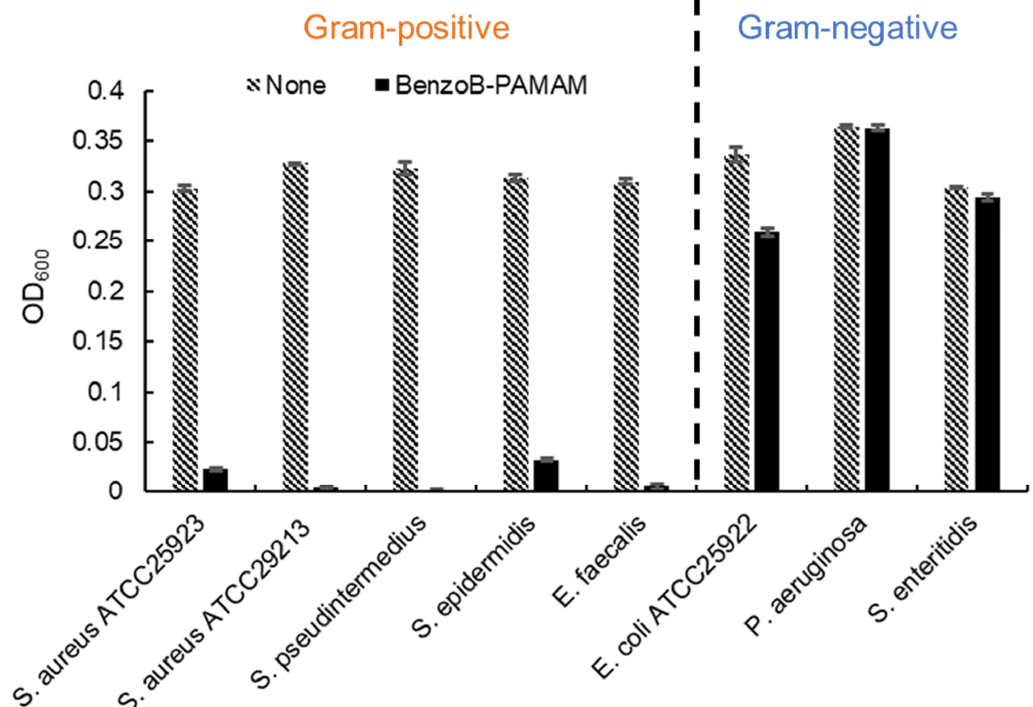
Figure 8. Turbidity experiments using various bacteria at a pH of 7.4, adjusted with PBS ( n = 3). [BenzoB-PAMAM(+)] = none or 3.3 × 10 − 6 M; bacterial concentration was set to OD 600 = 0.3. Bars represent SDs from three independent experiments.